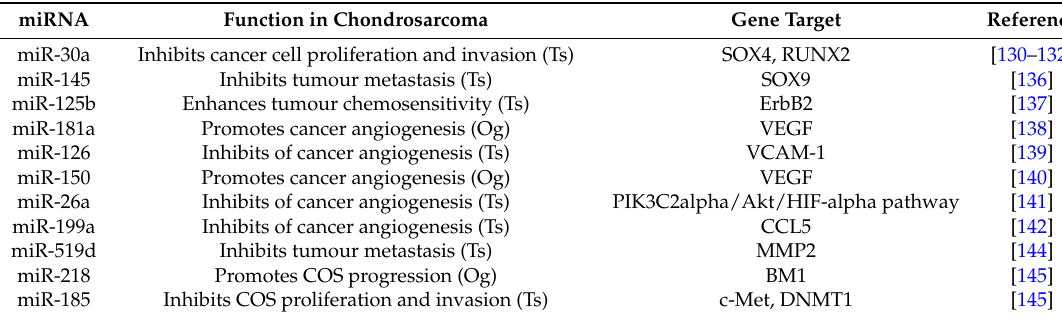
Table 1. Cancer-associated miRNAs in